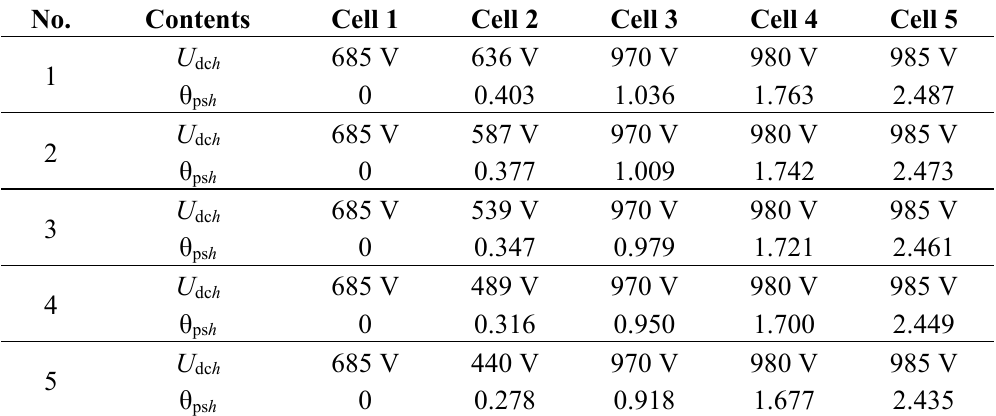
Table 2. Different combinations of unequal cell dc voltages and the carrier phases.